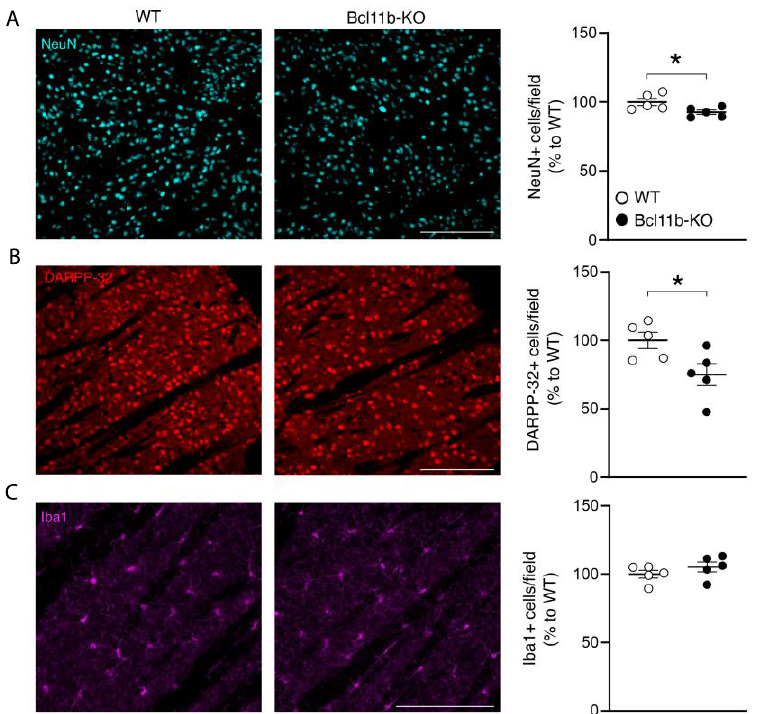
Figure 5. Bcl11b deficiency leads to a reduced number of MSNs without microgliosis. Represen- tative striatal images immunostained with cell type-specific markers, and graphs detailing corre- sponding quantification. ( A ). IHC of Bcl11b tm1.1Leid and control mice IHC immunostained with NeuN (neurons) and quantification. ( B ) . IHC of Bcl11b tm1.1Leid and control mice immunostained with DARPP-32 (MSNs) and quantification. ( C ) . IHC of Bcl11b tm1.1Leid and control mice with Iba1 (microglia). Scale bars, 200 mm. Graphs show the number of NeuN, DARPP-32, and Iba1-positive cells in the striatum. Each point represents an individual mouse. All data are shown as mean ± SEM (WT n = 5; Bcl11b -KO n = 5.) Two-tailed unpaired t-test, * p <